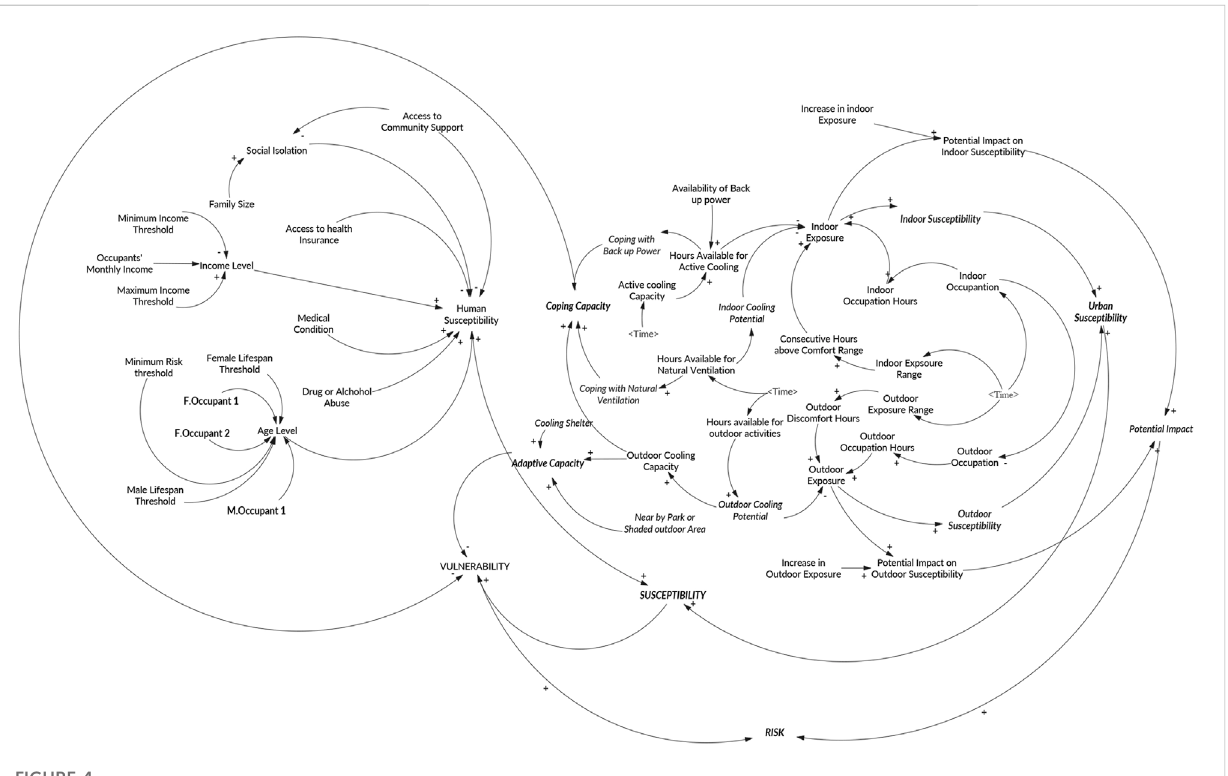
FIGURE 4 Structure of heat vulnerability SD model.